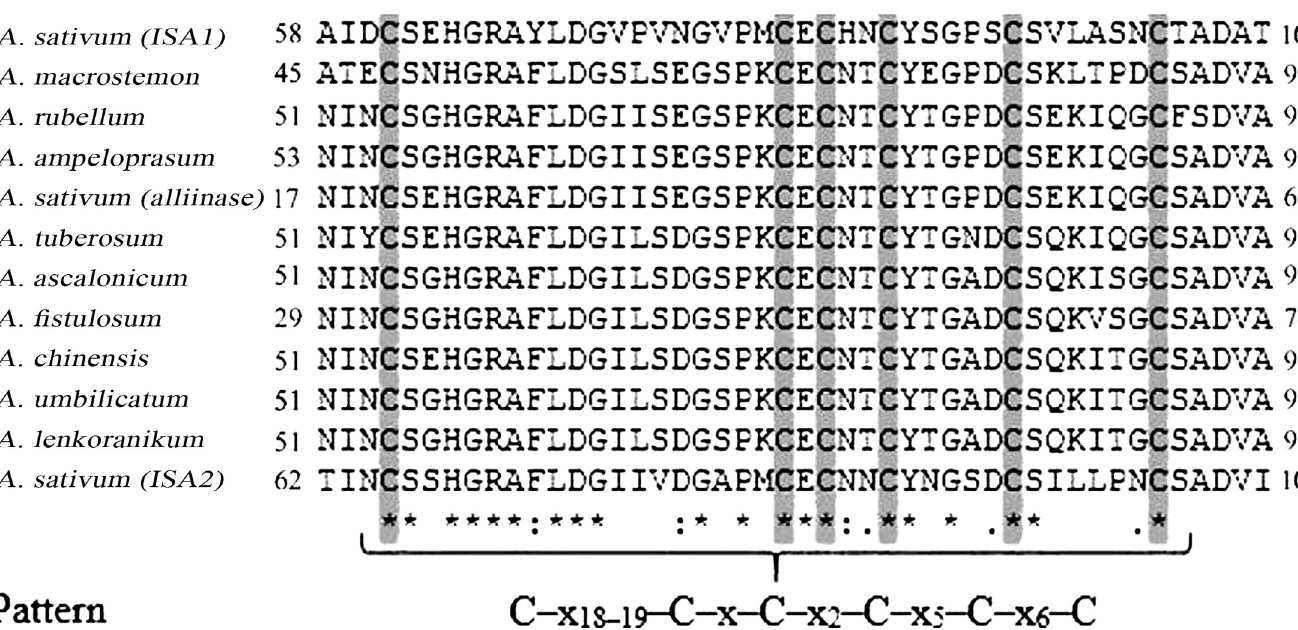
Fig 2. Sequence alignment of the N-terminal segments of iso-alliinases (ISA) protein sequences. Black letters on gray background, residues of conserved cysteine residues in EGF-like domain.